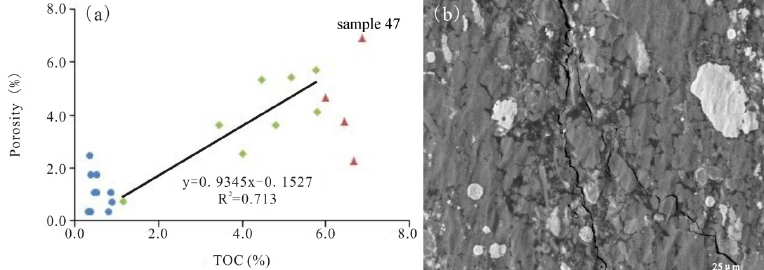
Figure 3. Relationship between total porosity and TOC content ( a ) and SEM image of sample 47 ( b ). In Figure 3a, red dots represent samples with TOC values over 6.0%, green dots represent samples with TOC values between 1.0% and 6.0%, and blue dots represent samples with TOC values below 1.0%.